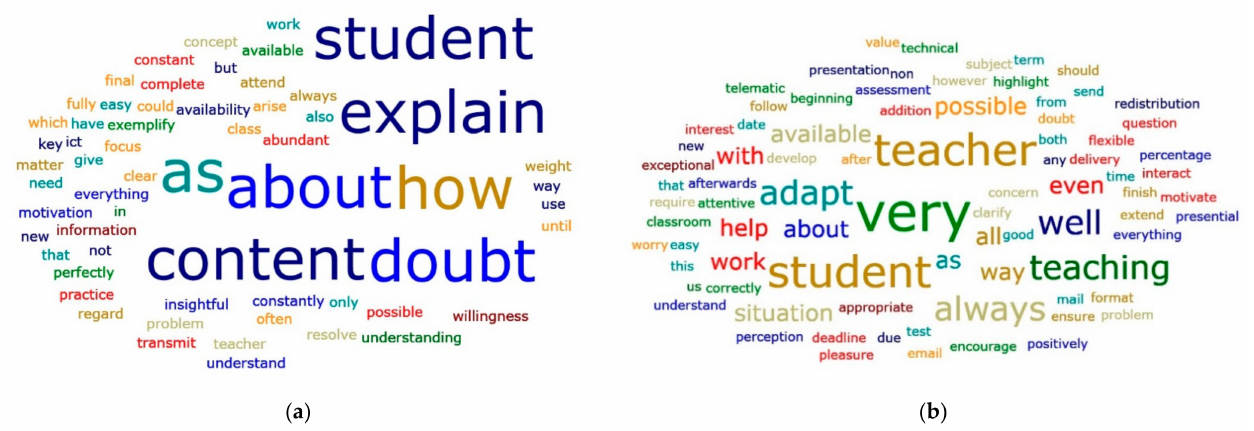
Figure 9. Word clouds on the answers to questions 1 ( a ) and 2 ( b ) in the QSOQT [45].